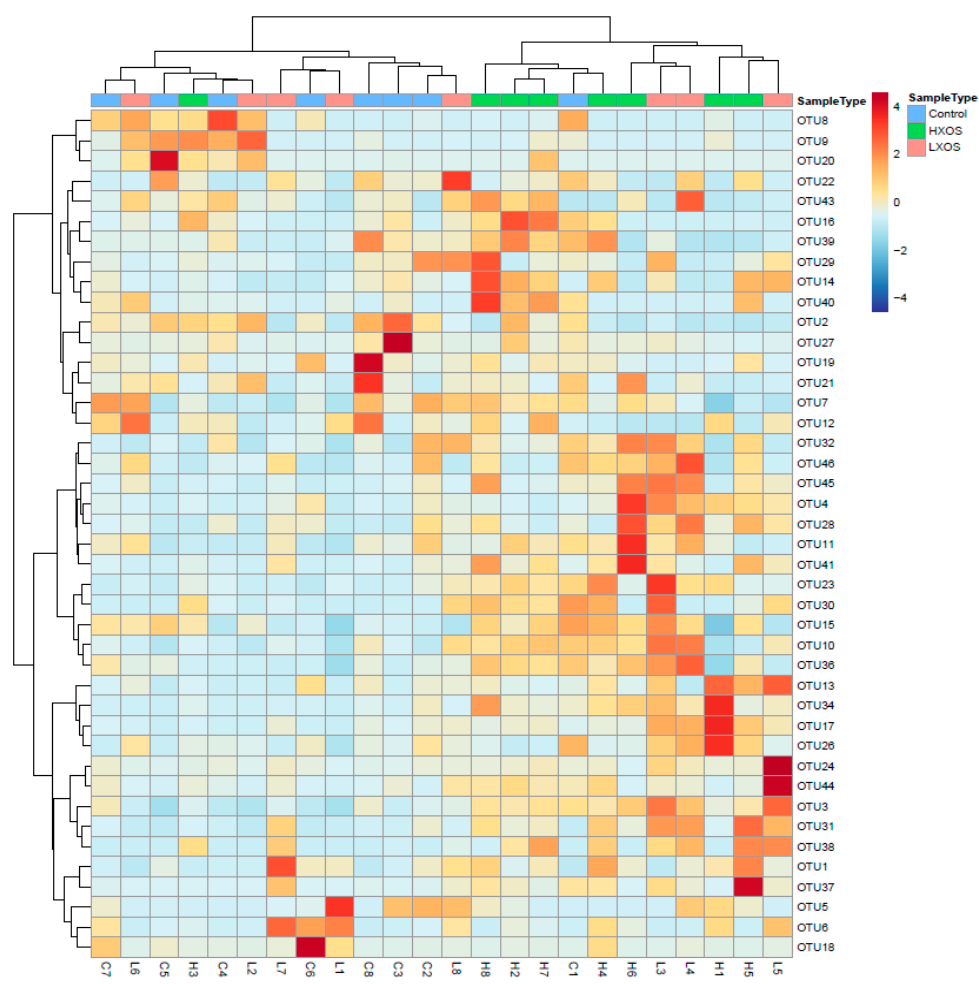
Figure 3. Heat map of the relative abundance and dendrogram clustering of the fecal microbiota genera. Colors with values represent log-transformed relative abundance of operational taxonomic units (OTUs).